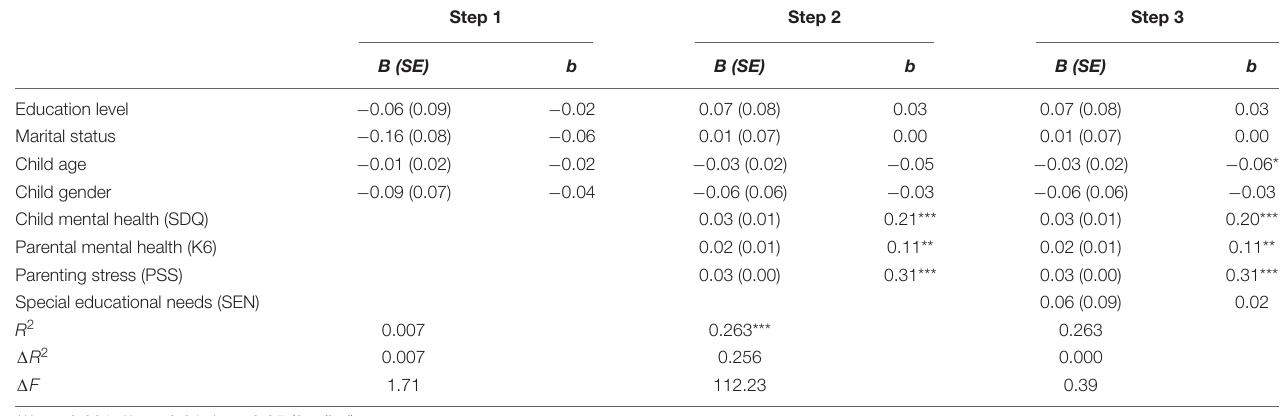
TABLE 4 | Hierarchical regression summary predicting co-existence difficulty during the lockdown in the United Kingdom.